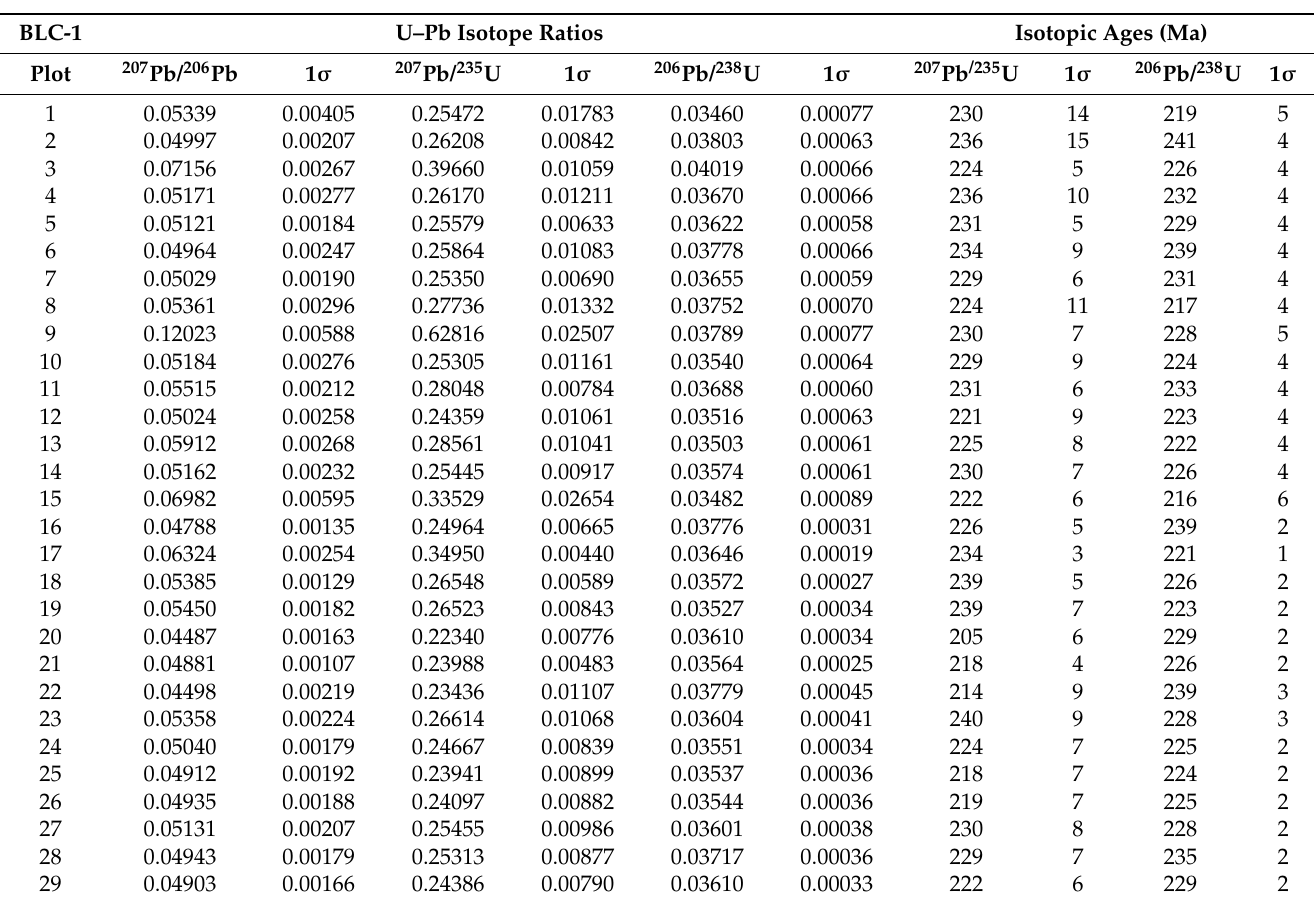
Table 1. Laser ablation inductively coupled plasma mass spectrometry (LA-ICP-MS) zircon U–Pb data for samplesBLC-1 and BLC-2,